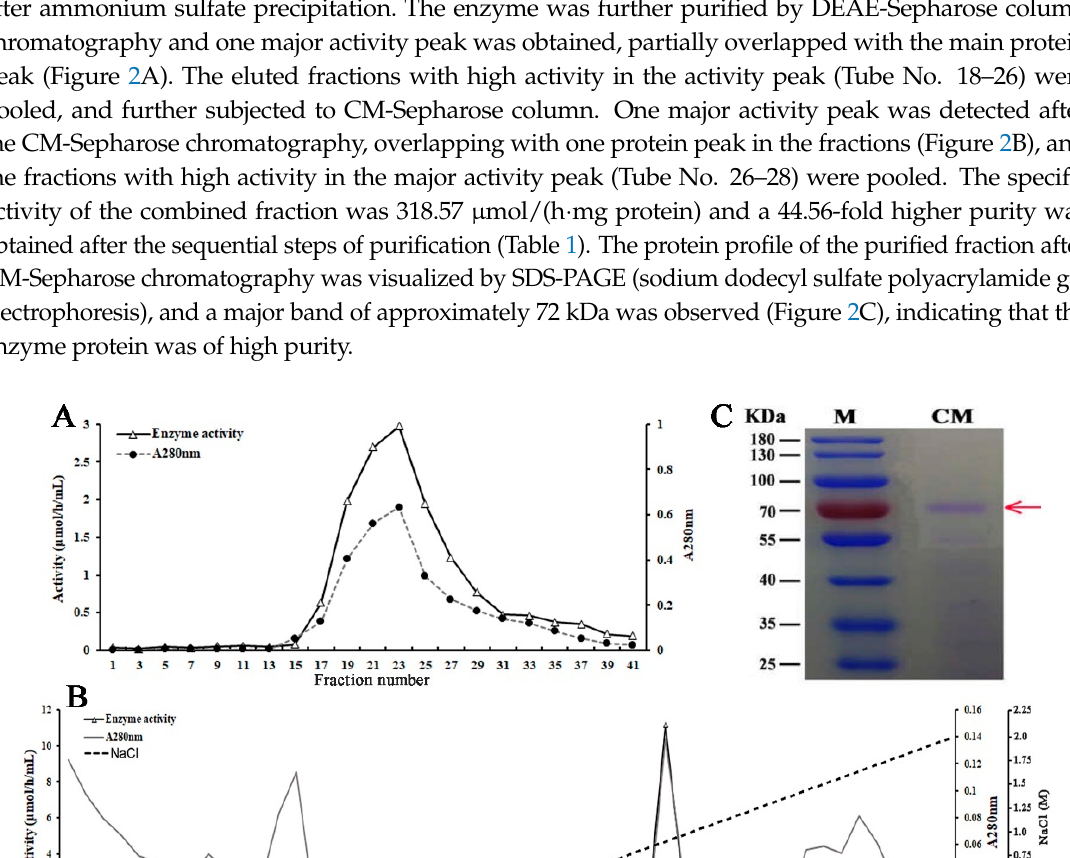
Table 1. Summary of the Purification Process of β -Glycosidases from B. calycina petals.